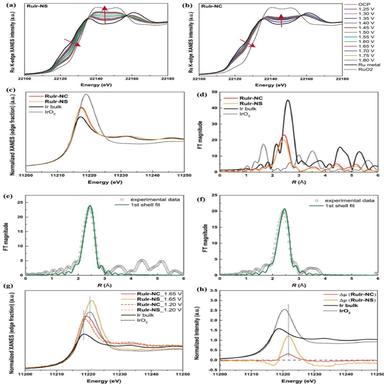
Quick XANES on the Ru K-edge and Ir L3-edge. (a) RuIr-NS and (b) Local structure of Ir sites. (c) Ir L3-edge XANES spectra of the as-prepared RuIr catalysts. (d) Ir L3-edge EXAFS spectra. The first-shell fitting of (e) RuIr-NC and (f) RuIr-NS. (g) Ir L3-edge XANES spectra of the as-prepared RuIr catalysts at 1.20 V and 1.65 V along with Ir and IrO2 as a comparison. (h) Ir L3 △μ (μ1.65 V-μ1.20 V) spectra.